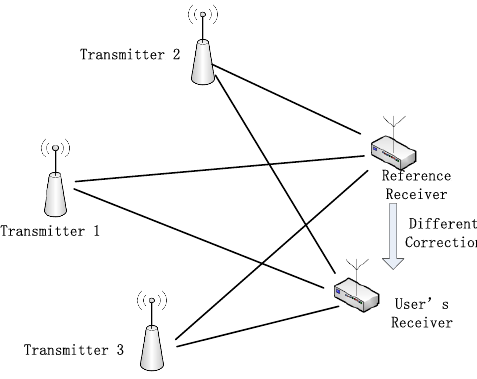
Figure 5. A scheme of the difference correction system.